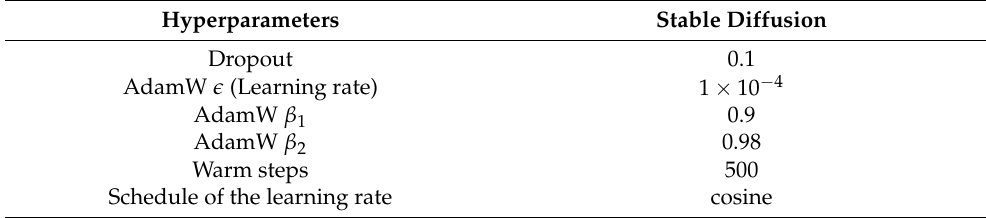
Table 5. Hyperparameters of the training